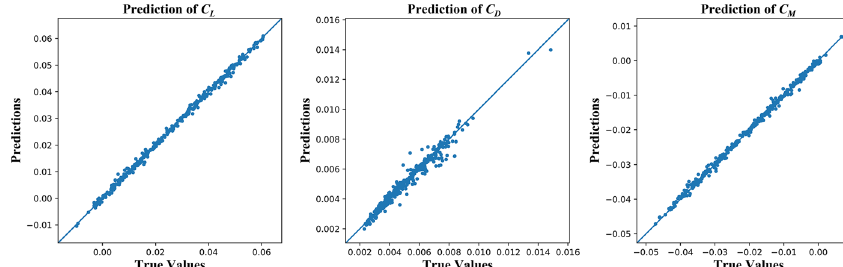
Fig. 20 Predicted versus CFD simulation values of C L , C D , and C M